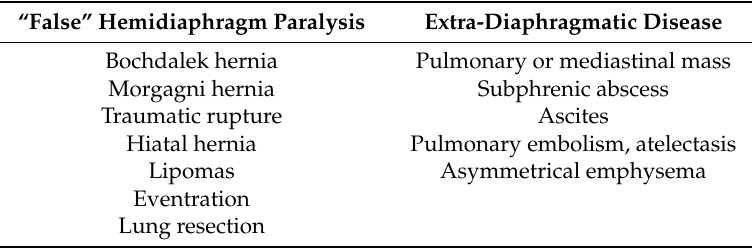
Table 1. Common alternative causes of an elevated hemidiaphragm image on a chest